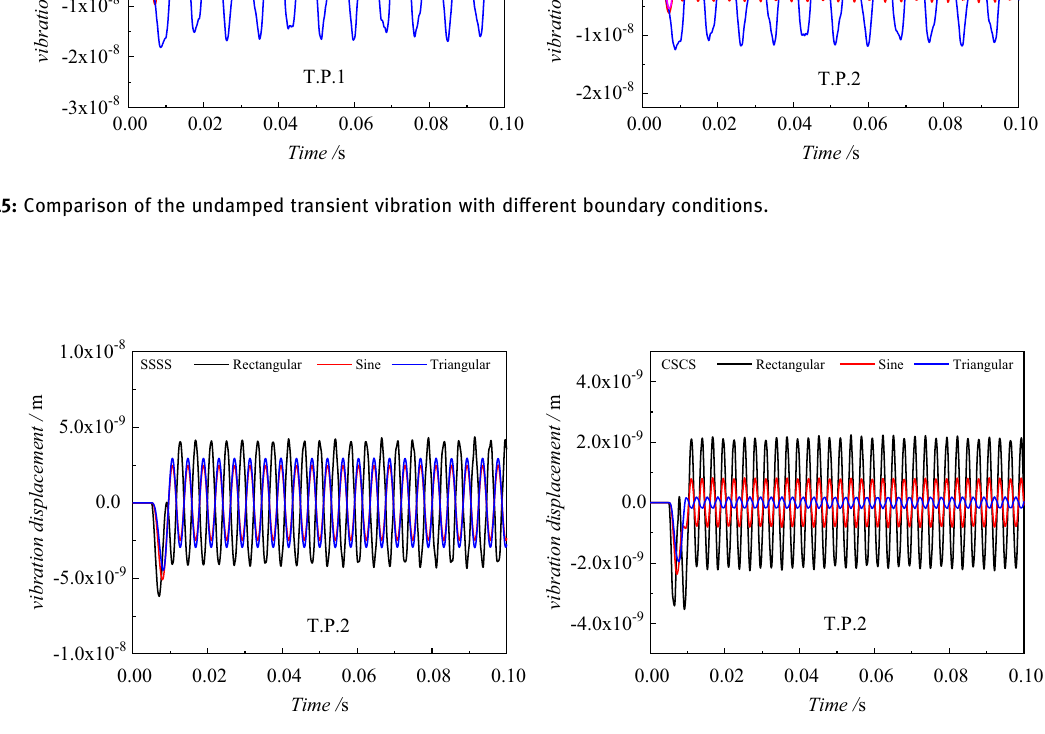
Figure 16: Comparison of the undamped transient vibration with di ff erent types of time - dependent loads.